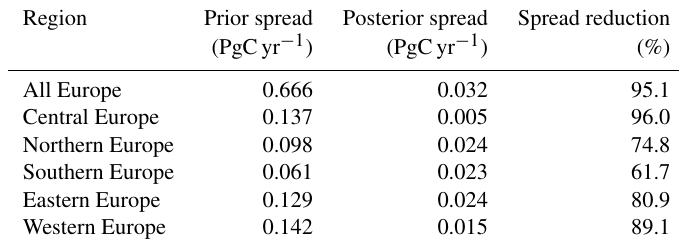
Table 3. Reduction in the biosphere ensemble NEE spread over Europe.